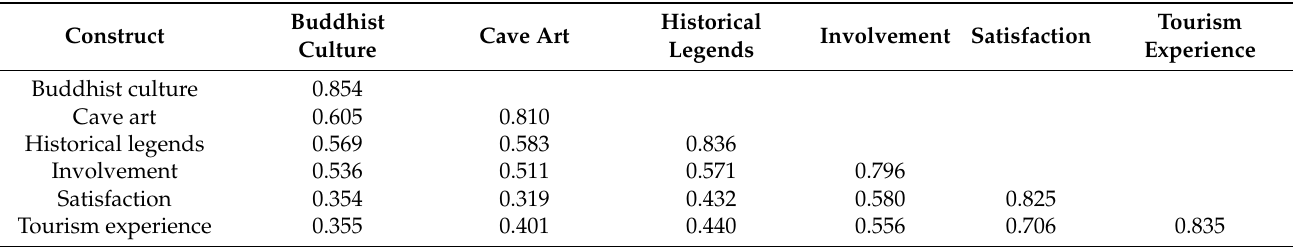
Table 6. Discriminant